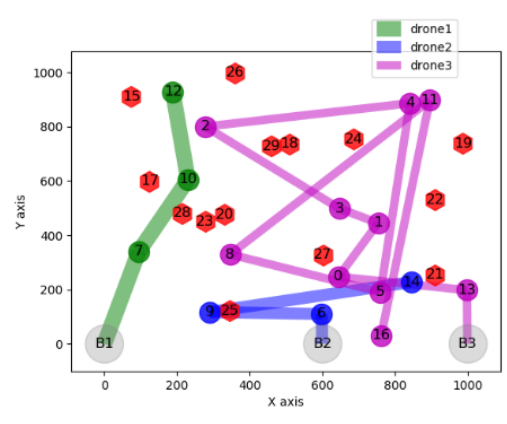
Figure 10. Path details (waiting =